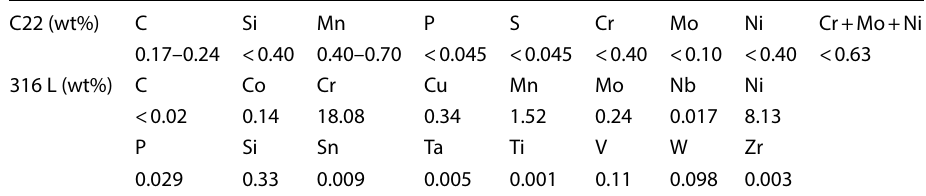
Table 1 Composition (in weight% - balance: iron) of the 2 steels: C22 and 316 L